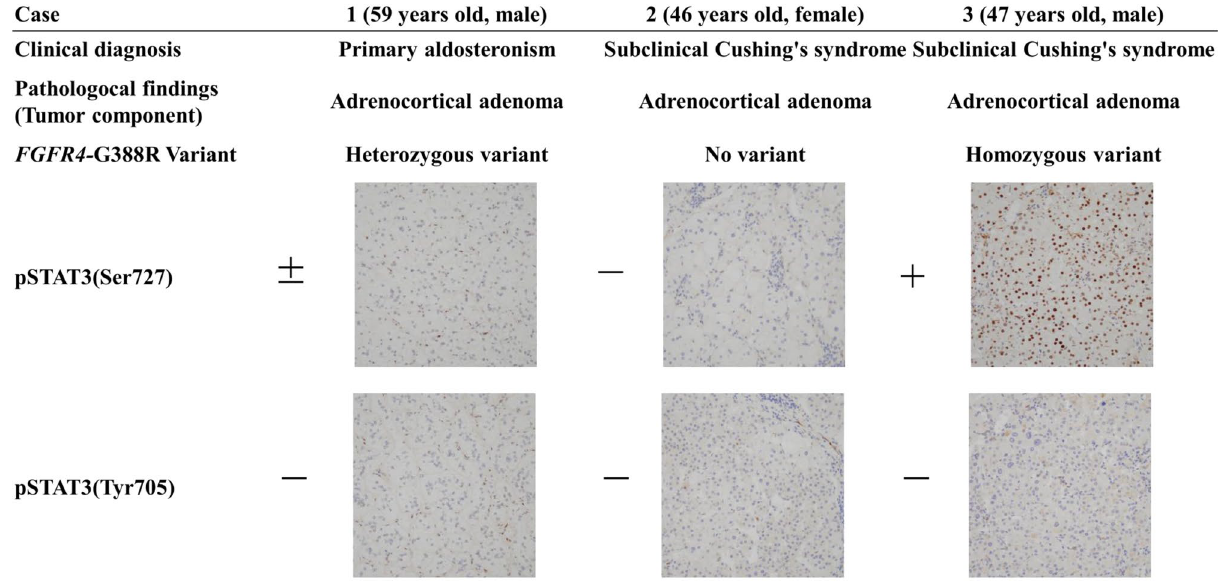
Figure 5. Sequencing analysis in FGFR4 -G388R variant and immunostaining of phosphorylated STAT3. Phospho-serine (p-S)727 STAT3 was strongly positive in the nucleus of the adrenocortical adenoma component of Case 3, and weakly positive in Case 1. Phospho-tyrosine (p-Y)705 STAT3 was not detected in any